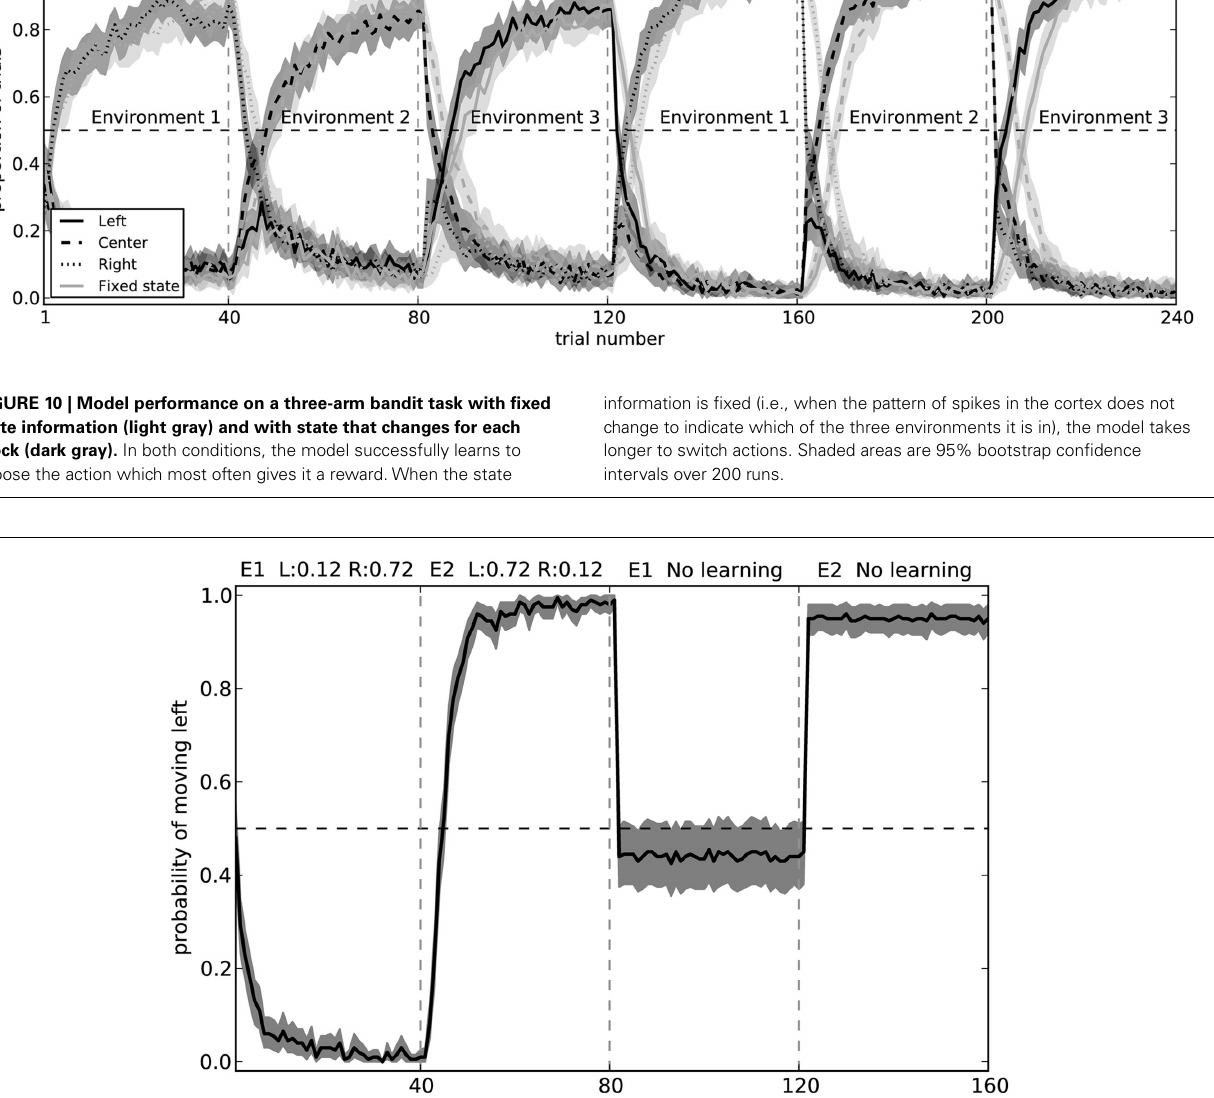
FIGURE 11 | Model performance when learning is turned off after the first 80 trials. Shaded area shows 95% bootstrap confidence intervals over 200 runs. A different randomly chosen state vector is used for each of the two